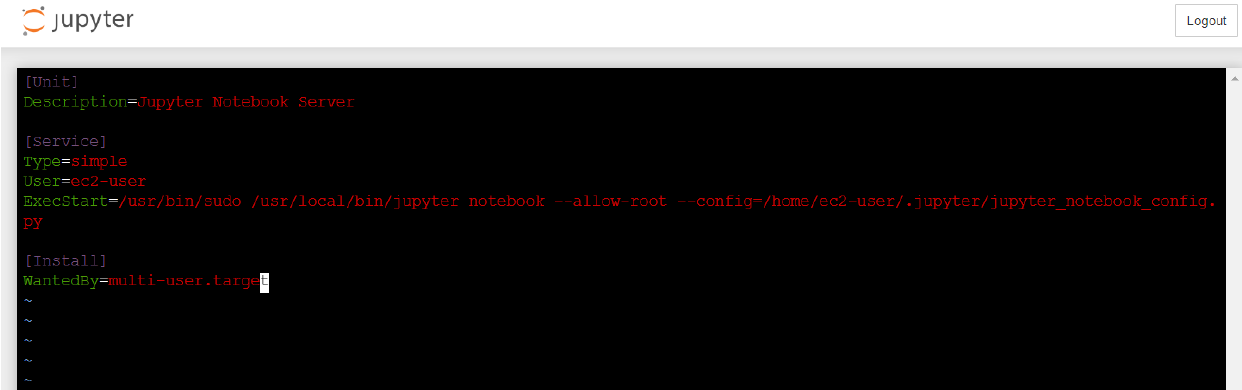
Figure 6. Jupyter Notebook